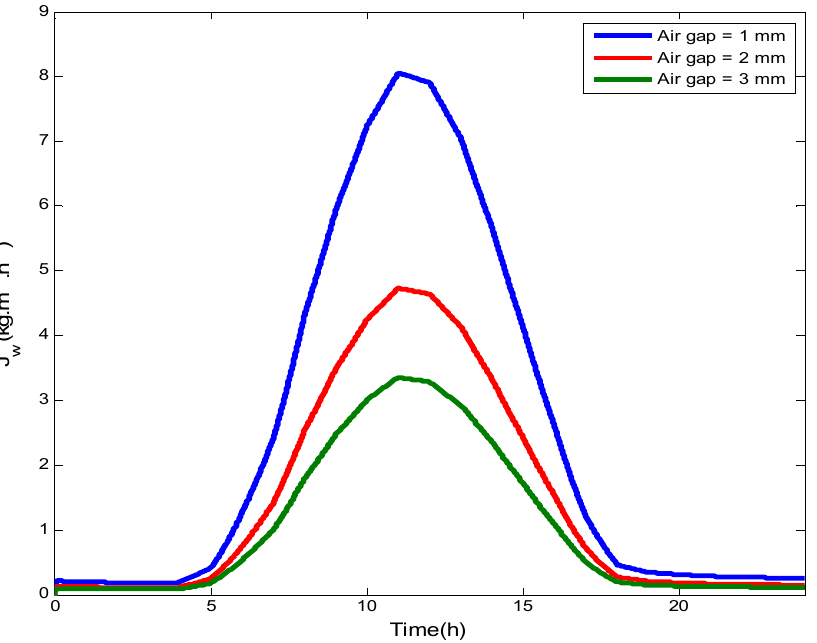
Figure 14. Variation of permeate flux with time at different air gap